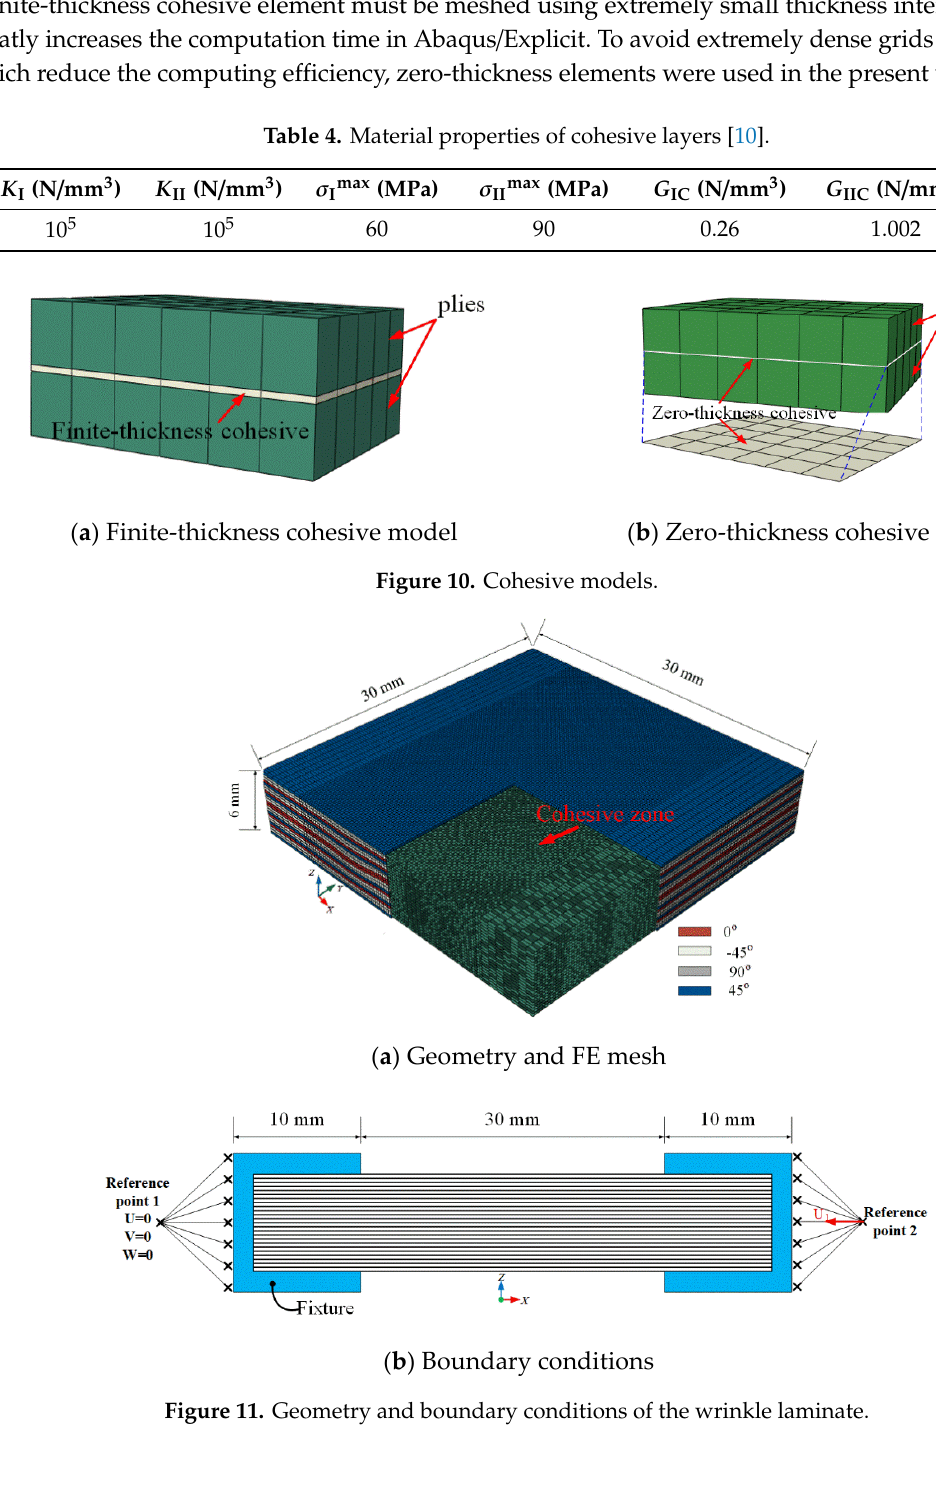
( b ) Boundary conditions Figure 11. Geometry and boundary conditions of the wrinkle laminate. 5.1. Compressive Failure Stress